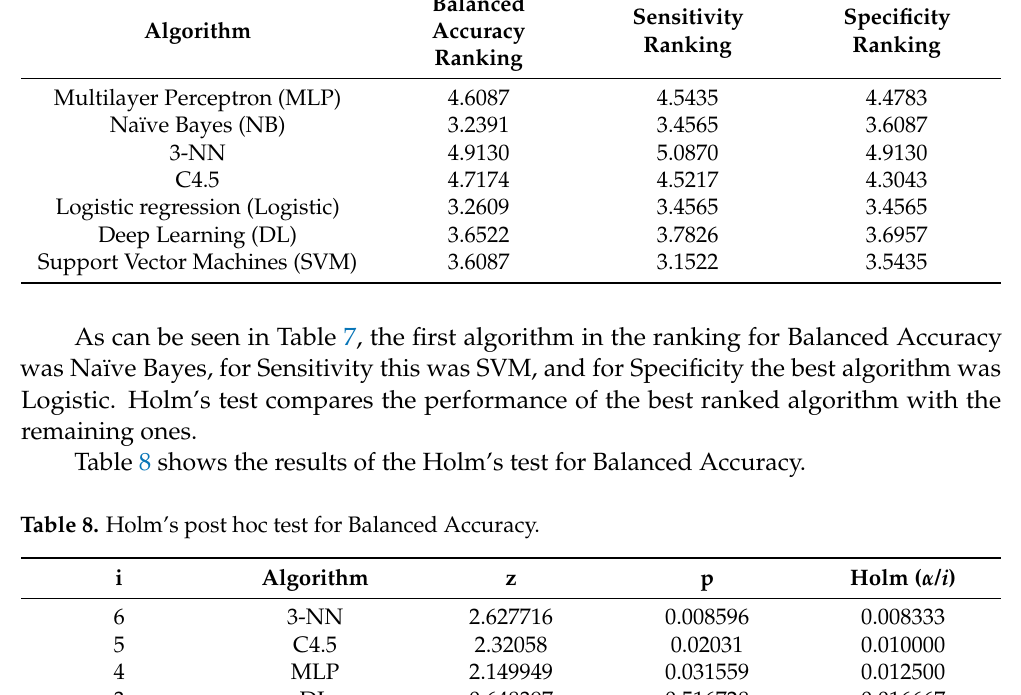
Sensitivity Ranking